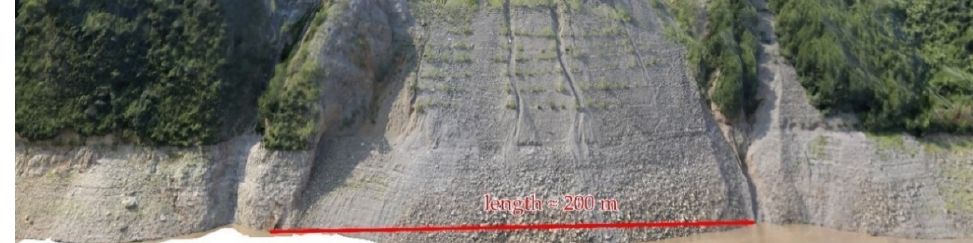
Figure 12. Length between the two endpoints at the bottom of the landslide measured from the four 3D models corresponding to each configuration. The true length is approximately 200 m, and the measurement results in the four 3D models are 199.96 m, 199.78 m, 199.68 m, and 199.45 m, respectively.